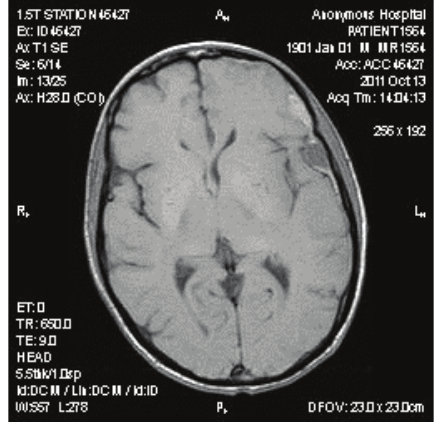
Figure 2: Brain MRI with and without contrast showing a nodular mass reflecting metastatic disease displacing the left inferior frontal